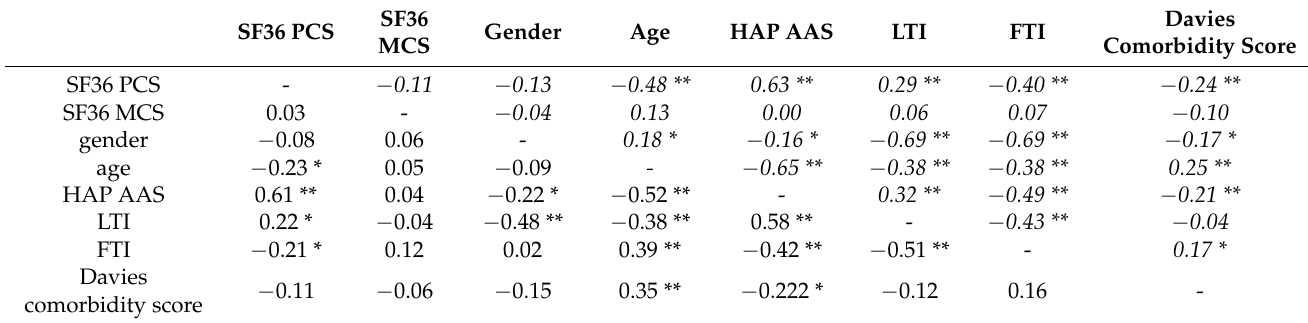
Table 3. The Pearson’s r for observed